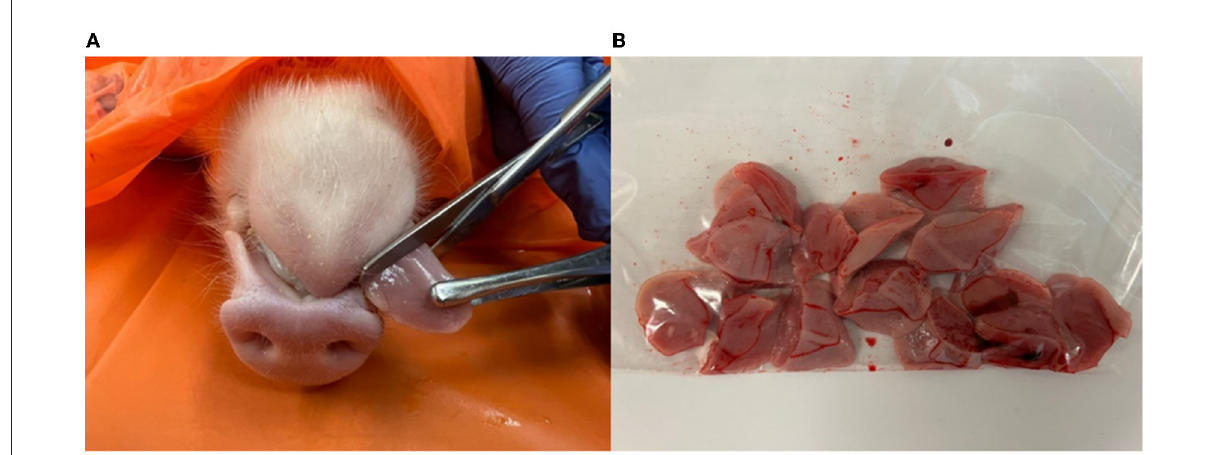
FIGURE2 Tongue tip collection. Tongue tips were held from the dead piglets with Russian Tissue Forceps, severed with Mayo Dissecting 6.5” Straight Blunt Scissors ( ≈ 2cm) (A) , and placed in a disposable plastic bag (B) .